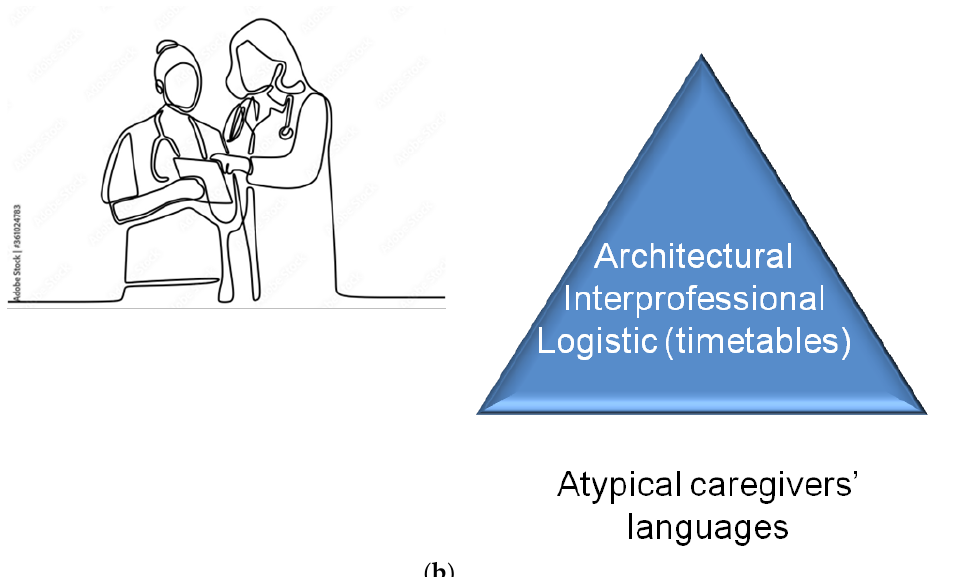
Figure 1. ( a ) Patients’ multiple languages. ( b ) Three atypical ways of communication.